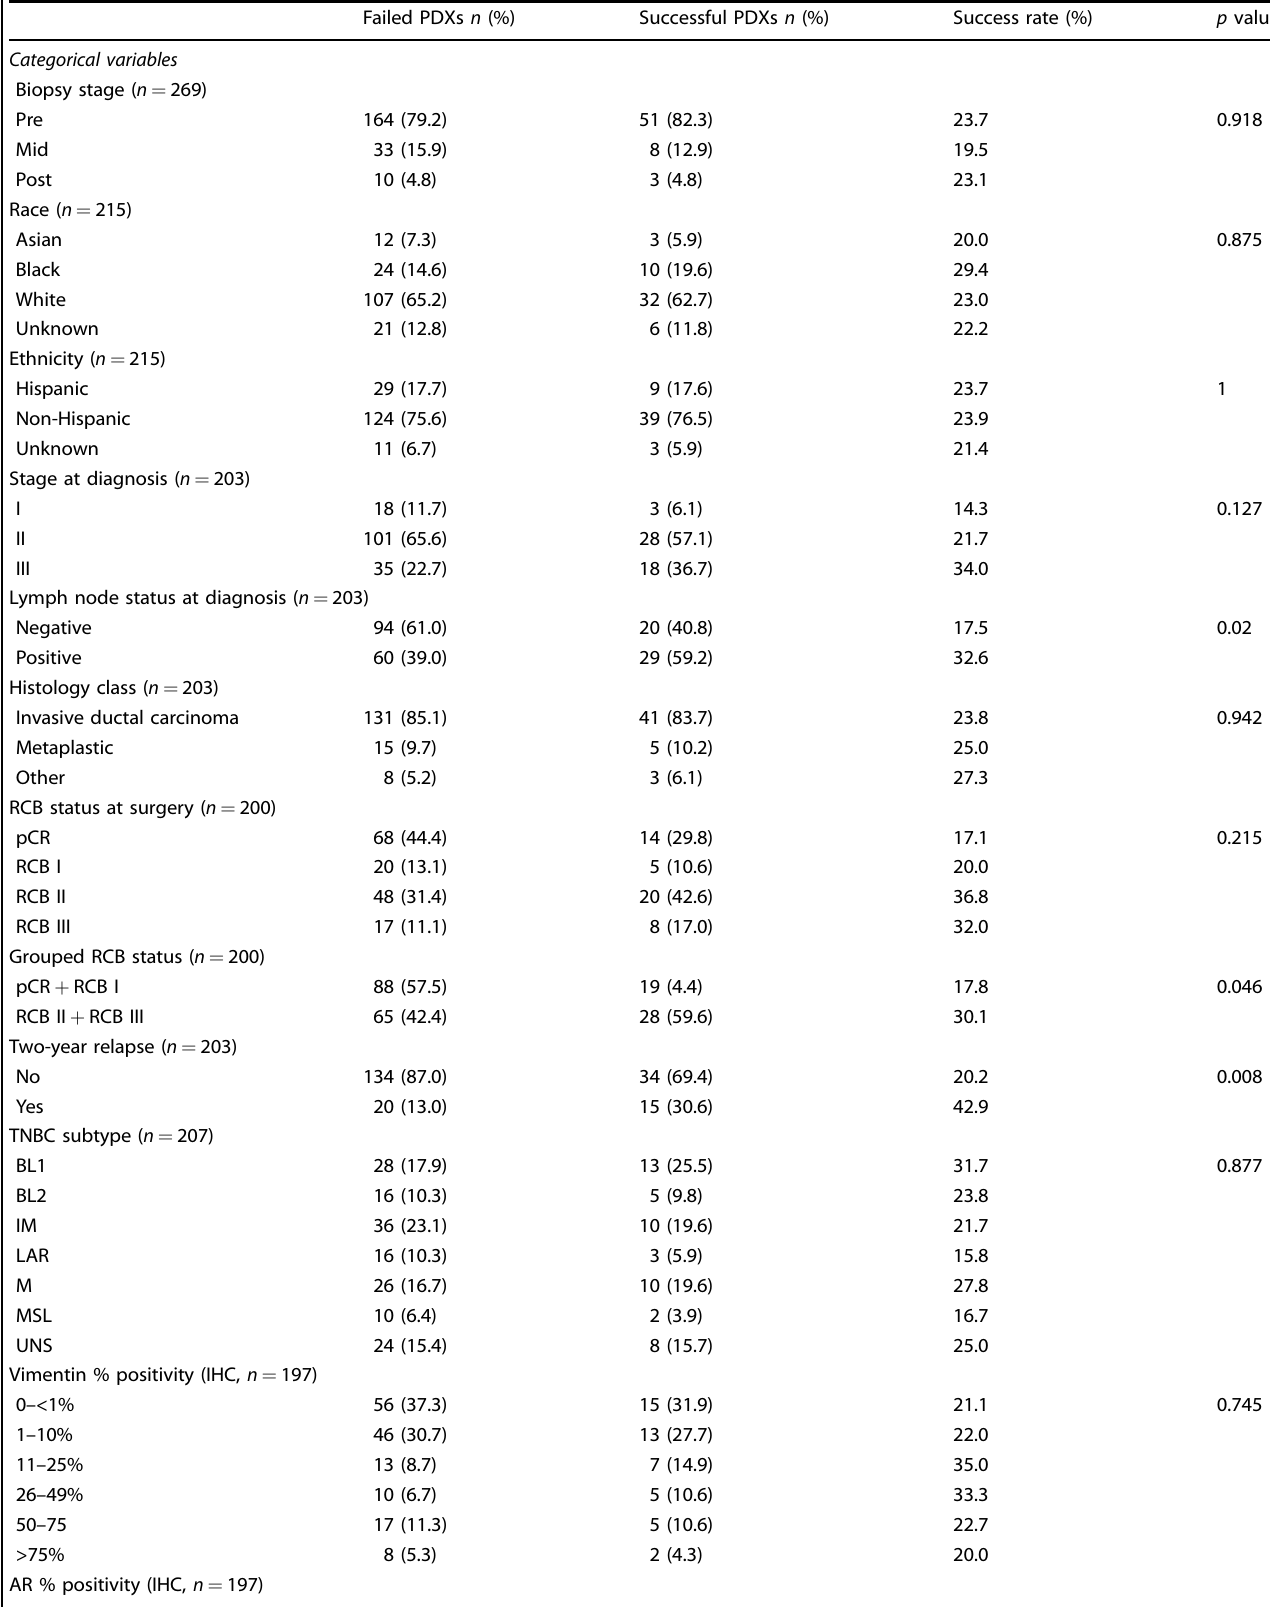
Table 1. Clinical variables of pre-NACT biopsies analyzed for correlation with PDX